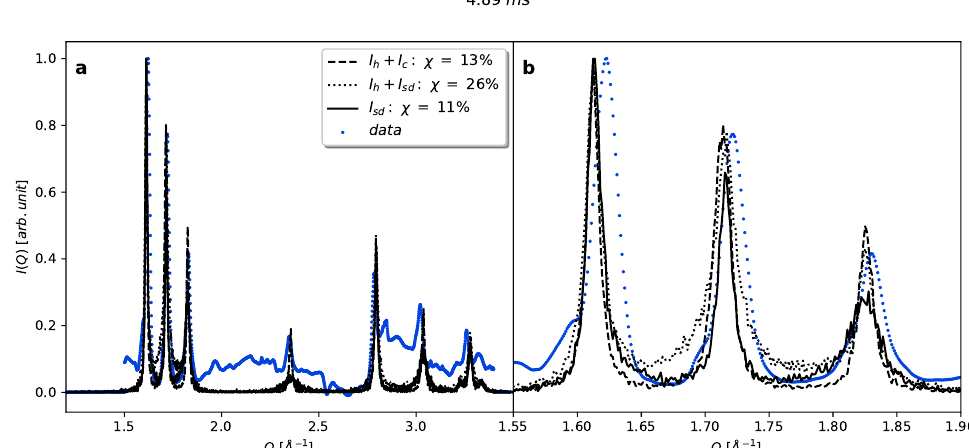
Figure A13. ( a ) Cubicity estimate for cubic and hexagonal mixture calculated from the peak heights of (002) and (101) of the hexagonal ice (black dashed), for hexagonal and stacking-disordered mixture (black dotted) and for pure stacking-disordered ice (solid black) together with the experimental data at 4.89 ms travel time (green circles). ( b ) A zoom-in on the first three peaks of the models and